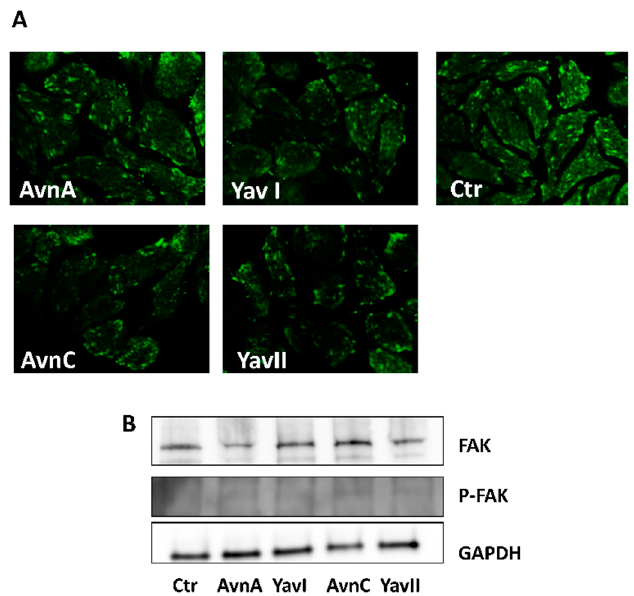
Figure 6. Effects of natural and yeast-derived avenanthramides on focal adhesion kinase (FAK) expression and phosphorylation. ( A ) Representative images of immunofluorescence analysis of FAK in HT29 cells treated with either Avn-A, YAvnI, Avn-C or YAvnII (200 µM, 48 h); ( B ) Western blot analysis of FAK expression and phosphorylation (P-FAK) levels in HT29 cells treated with either Avn-A, YAvnI, Avn-C or YAvnII (200 µM) for 48 h. Images are representative of three different experiments.